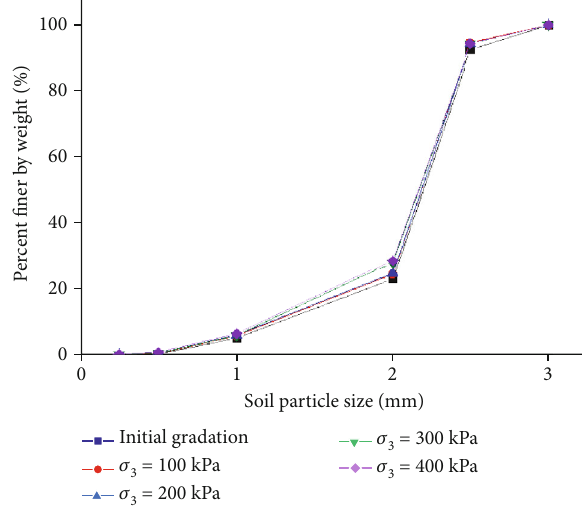
~ σ / p Figure 9: Grading curve of calcareous sand under di ff erent max m a diagram. e ff ective con fi ning pressures.